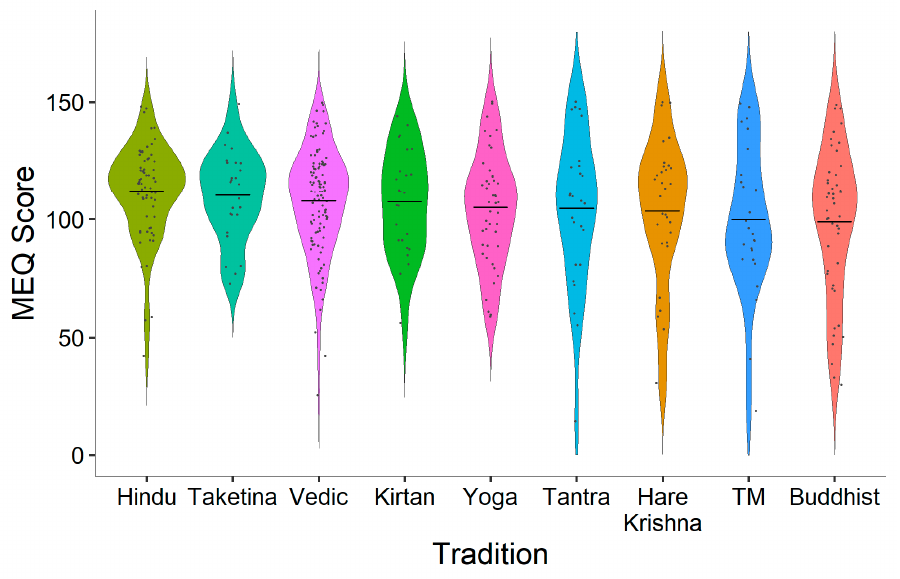
Figure 3. Total mystical experience scores by tradition. Table 2. Revised mystical experience questionnaire (MEQ30) subscale mean and standard deviation (in parentheses) scores by